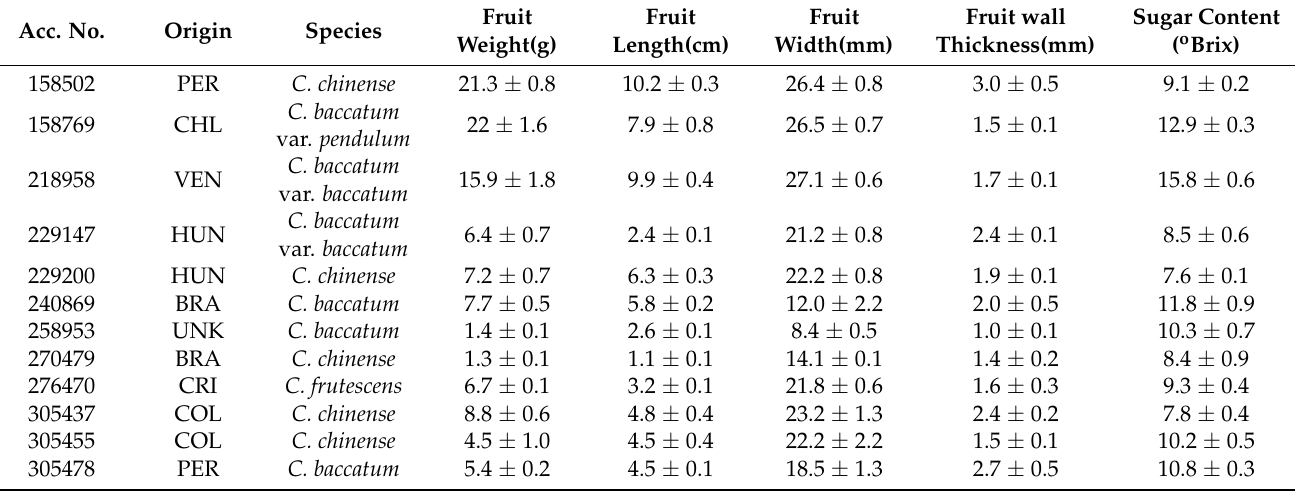
Table 5. Fruit characteristics of selected anthracnose resistant Pepper genetic resources. Acc.